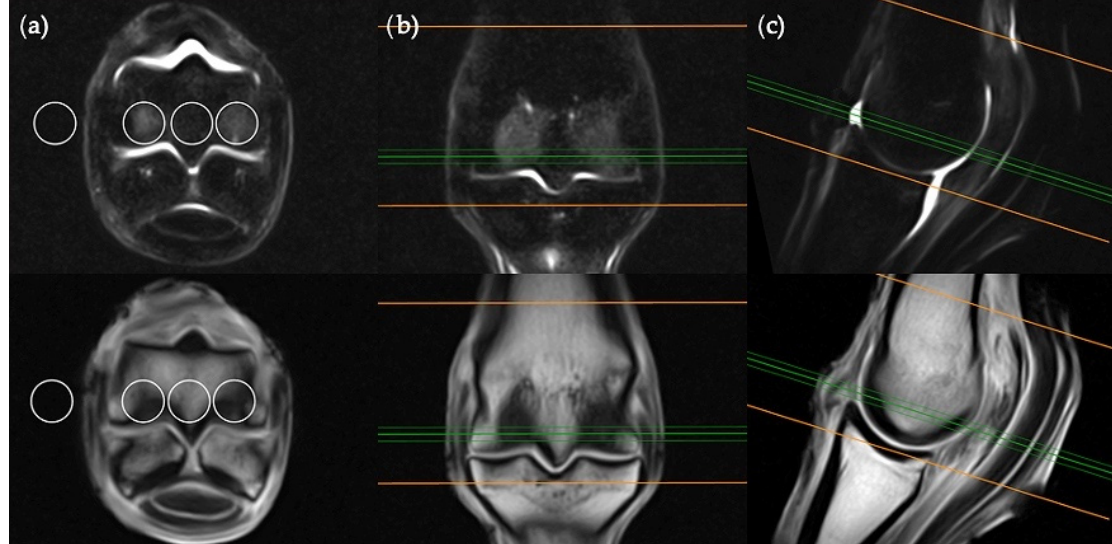
Figure 2. STIR FSE (top row) and T1W GRE (bottom row) MRI images in ( a ) transverse; ( b ) frontal and ( c ) sagittal planes; demonstrating the location of ROI placements in a transverse plane. The green lines on the frontal and sagittal images show the standardized orientation and location of the transverse slice for ROI placement. The orange lines show the extent and orientation of all the transverse slices acquired in the MRI